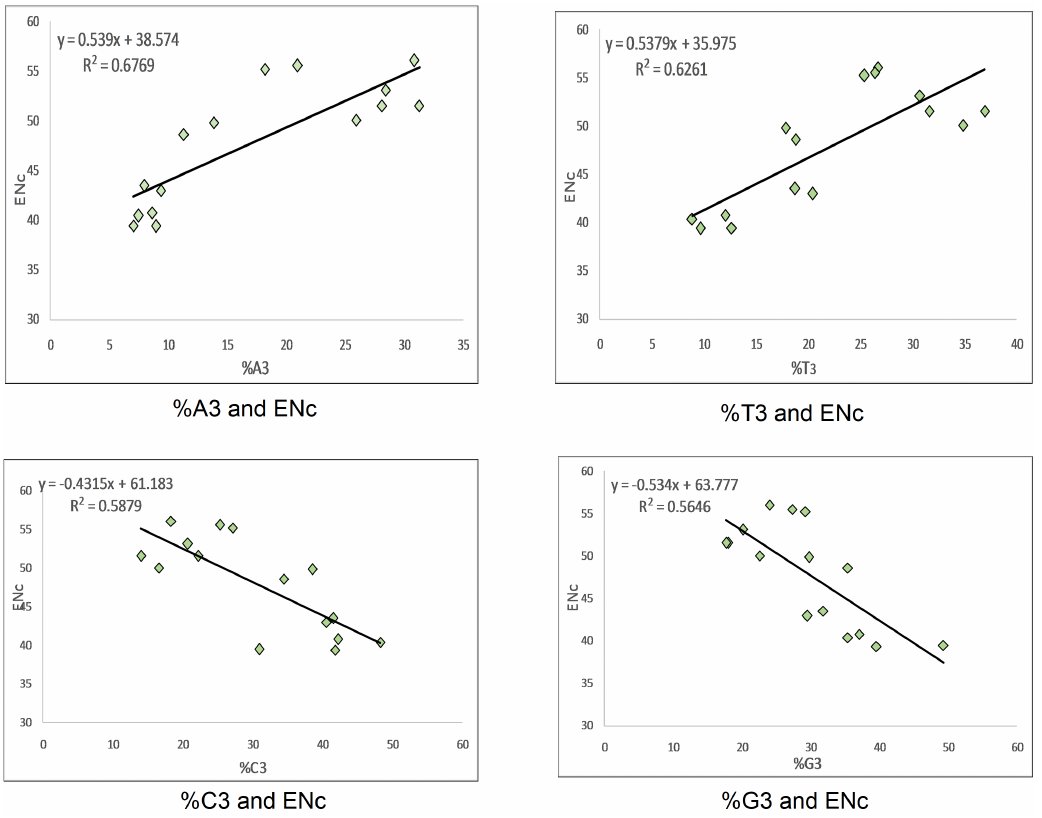
Fig. 8. Regression analysis between ENc and nucleotide composition at third codon position to determine effects of mutational force on ENc. The contribution of mutational force on the CUB was least for nucleotide C, while the mutational force on three nucleotides (A, T and G) contributed almost equally for CUB (approximately 53%).